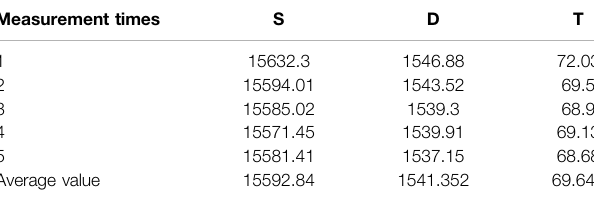
TABLE 2 | Multiplicity measurement of the 252Cf standard source. Measurement